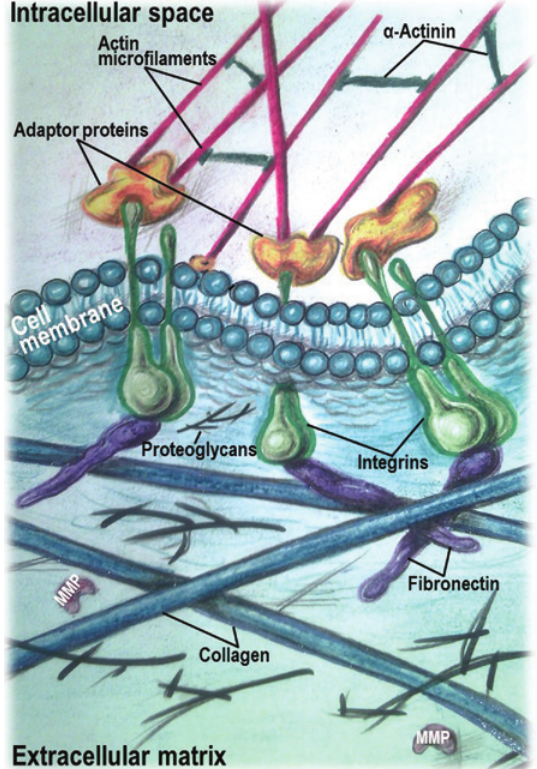
Figure 2: Schematic diagram illustrating a linkage between the extracellular matrix and the actin cytoskeleton by integrins. The extracellular domain of integrins interacts with the extracellular filaments through adaptor cytoskeletal